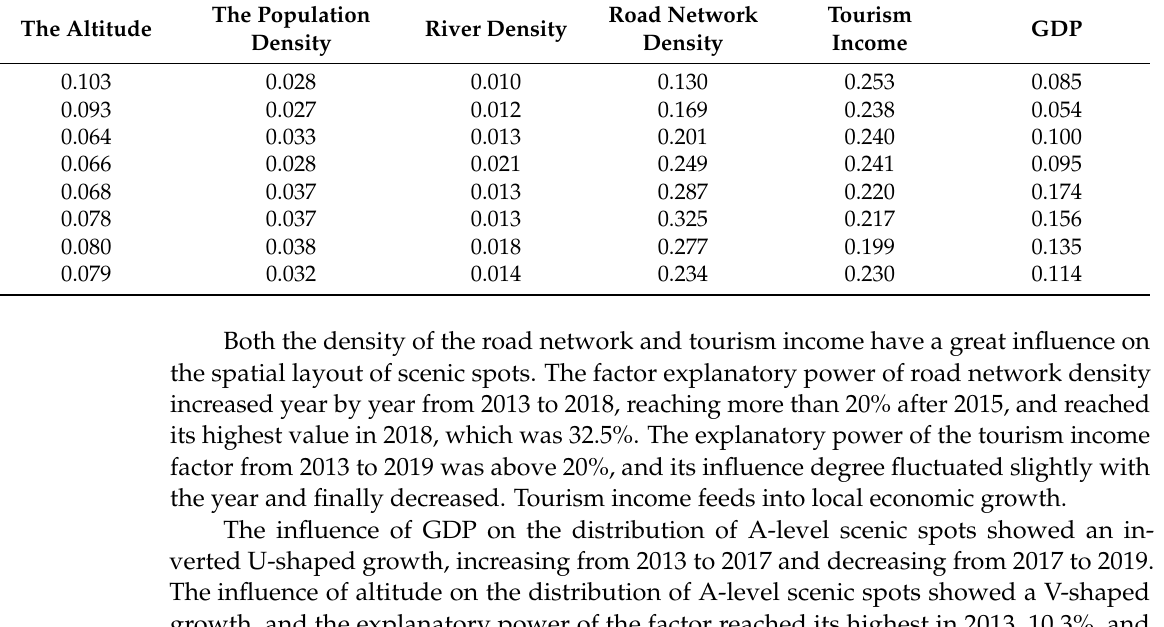
Table 5. Detection results of the spatial evolution influencing factors of A-level scenic spots in Guizhou Province. Year The